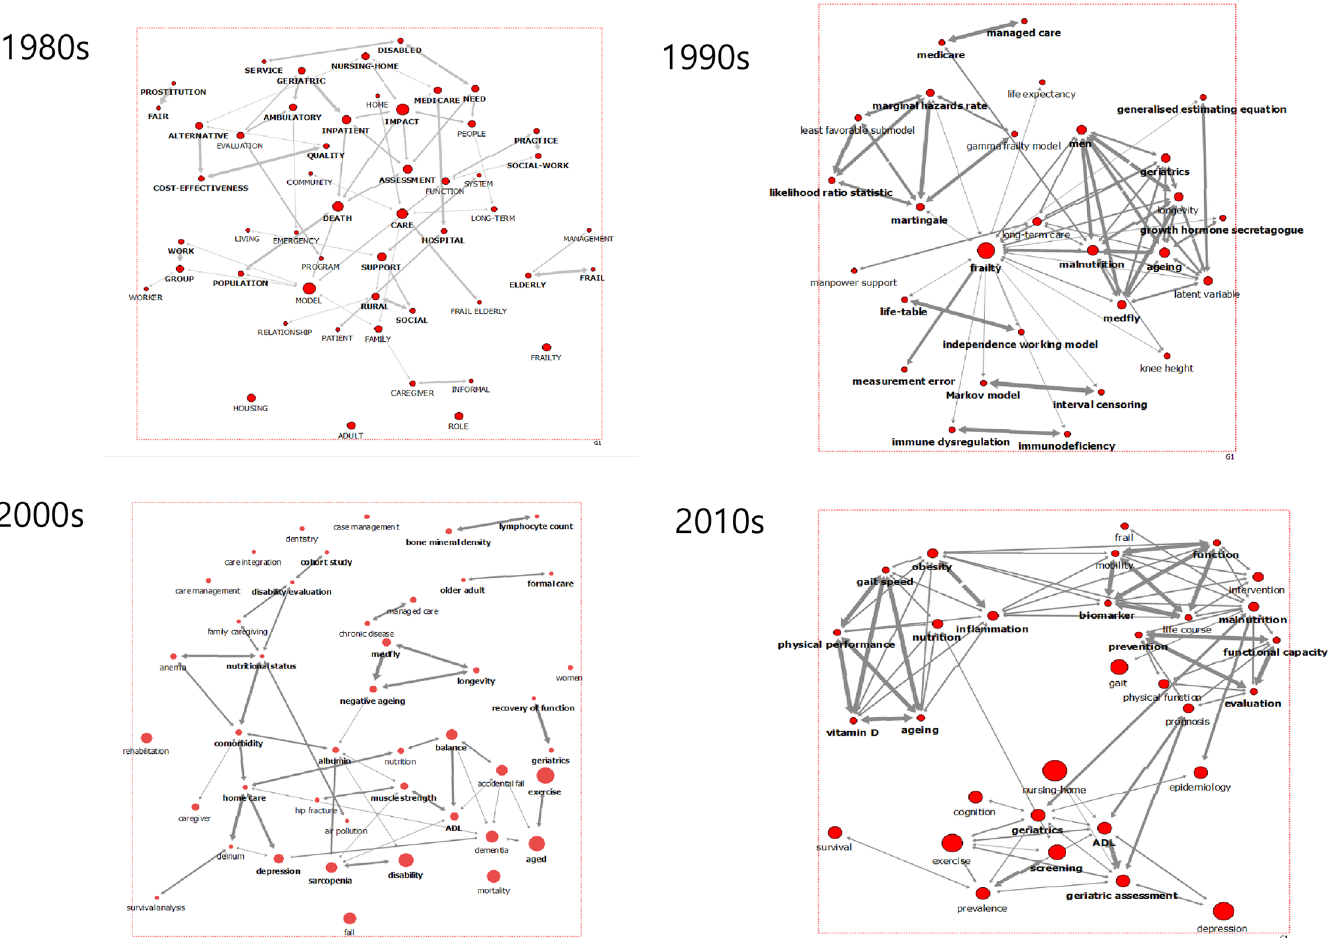
Fig 3. Communities through 40